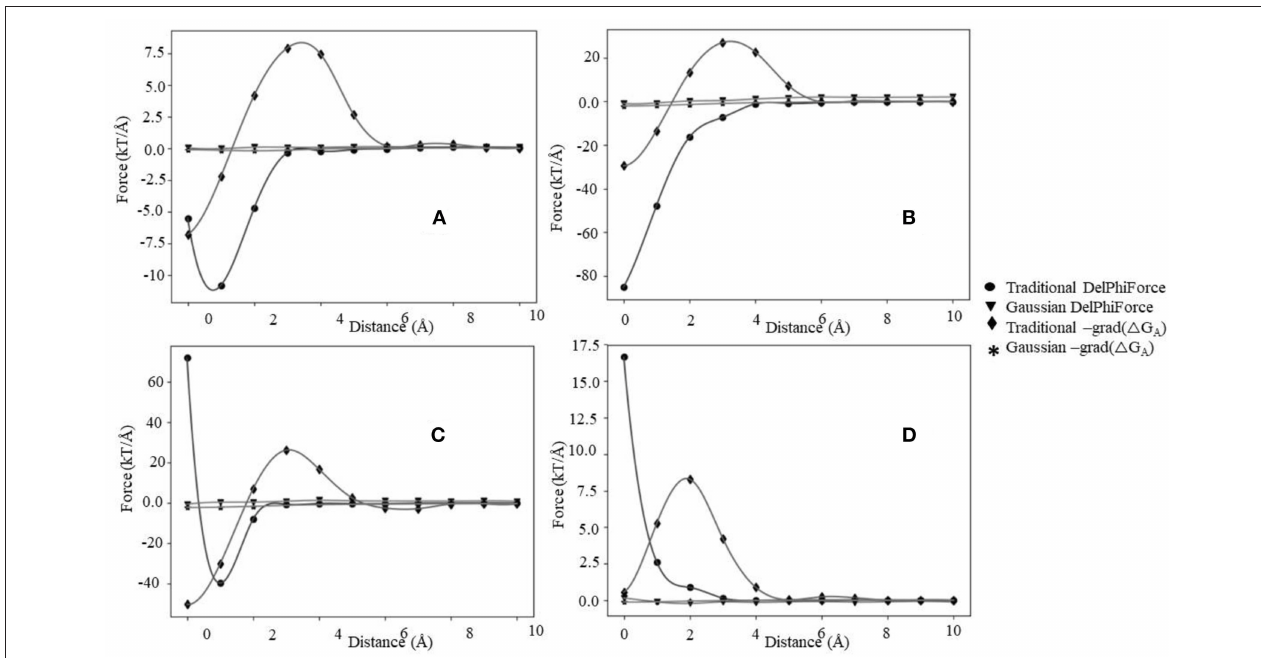
FIGURE 5 | The electrostatic forces (F int and F ene ) profiles, (A) maximum attraction force at a particular distance, (B) maximum attraction force in the bound state, (C) soft landing, and (D) repulsive force.